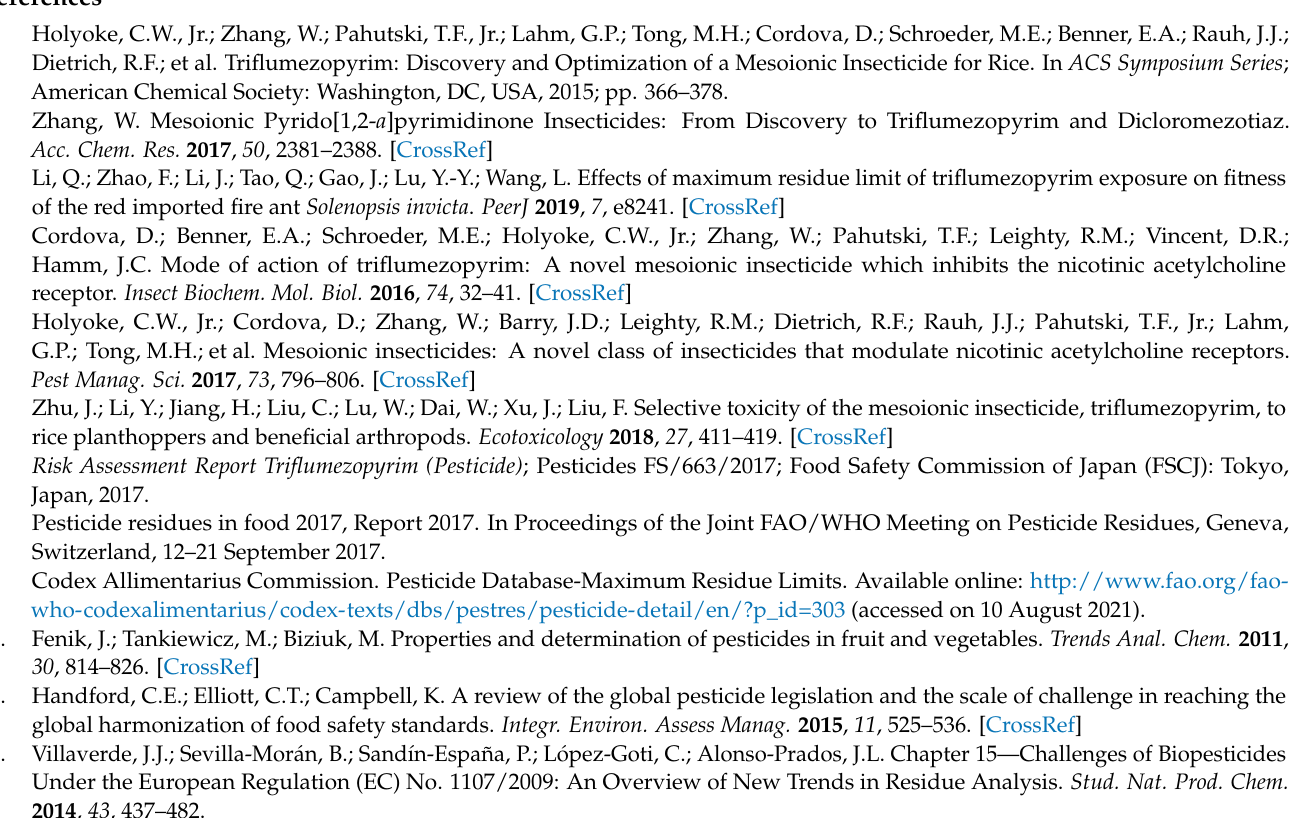
triflumezopyrim using UPLC-MS/MS, Table S3: Scheme for preparing matrix-matched calibration standards, Table S4: Effect of NaCl and MgSO4 for extraction efficiency of triflumezopyrim, Table S5: Comparisons of d-SPE adsorbent for purification efficiency of triflumezopyrim, Figure S1: Experi- mental procedure for the determination of triflumezopyrim residue in food, Figure S2: LC-MS/MS chromatograms for triflumezopyrim standard solution at concentration of 0.1 mg/kg in acetonitrile, Figure S3: LC-MS/MS chromatograms for triflumezopyrim standard curves, Figure S4: Representa- tive MRM (qualification ion 399 > 121) chromatograms of triflumezopyrim residue, Figure S5: Repre- sentative MRM (qualification ion 399 > 306) chromatograms of triflumezopyrim residue, Figure S6: Inter-laboratory comparison of triflumezopyrim residue (qualification ion 399 > 121), Figure S7: Inter-laboratory comparison of triflumezopyrim residue (qualification ion 399 >